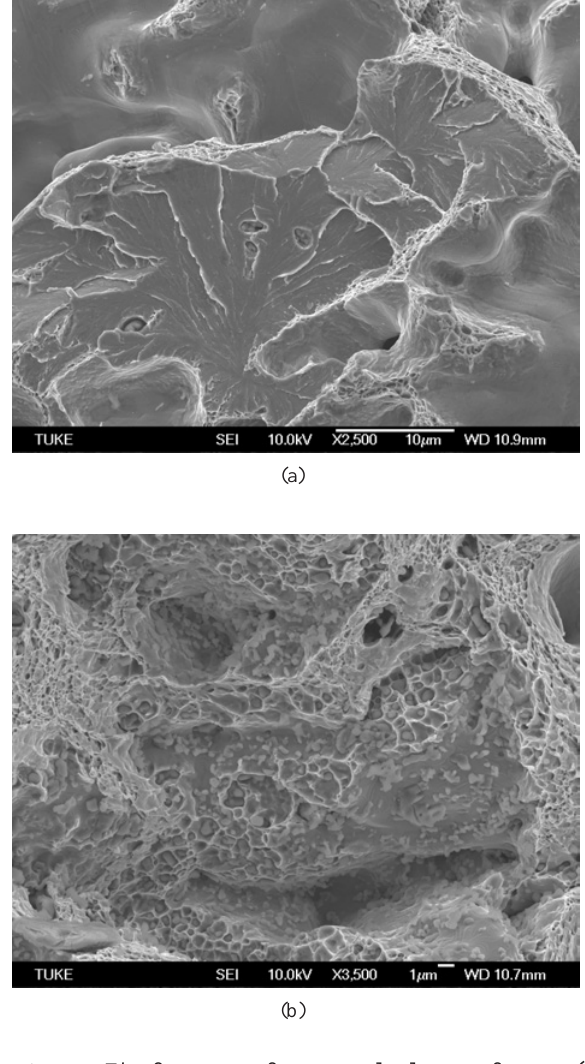
Figure 4. The fracture surfaces reveals cleavage features (a) and contamination, mainly oxide, presence (b), cooled at 3 K =